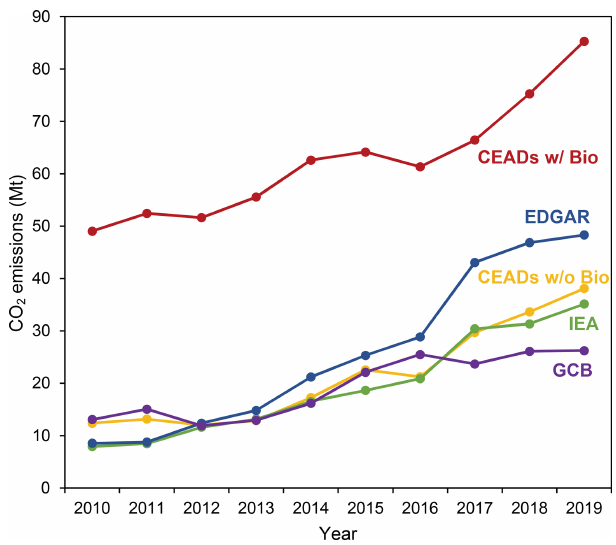
Figure 4. CO 2 emissions of Myanmar from different institutes for 2010–2019. Different colors represent the sourced datasets: red for CEADs with biomass emissions, blue for EDGAR, yellow for CEADs without biomass emissions, green for IEA. and purple for GCB.